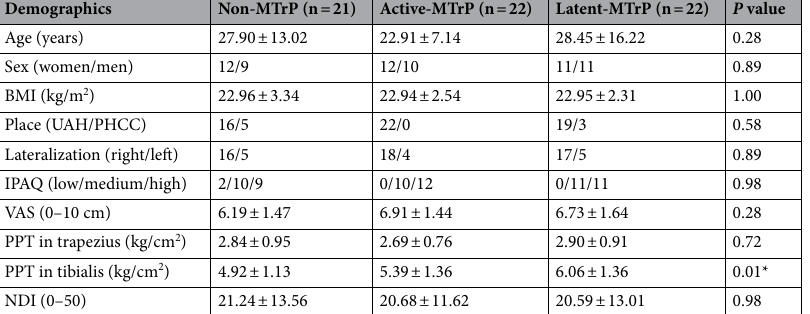
Table 1. Demographic and clinical characteristics at baseline. Values are expressed as the mean ± standard deviation or number of participants. BMI body mass index, UAH University Alcalá Henares, PHCC